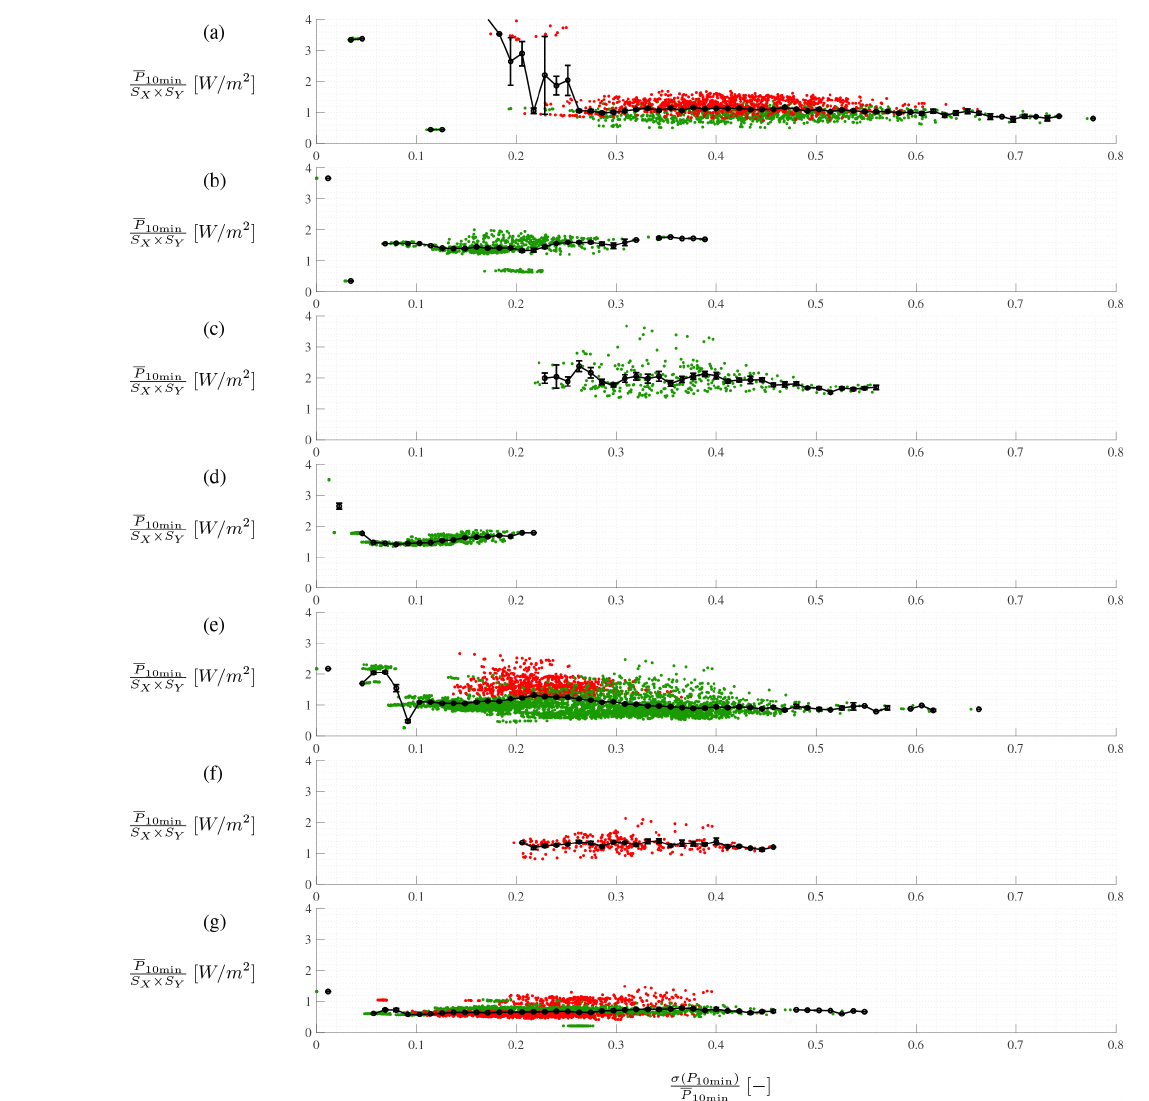
√ ( S X × S Y ) = 10 . 95 R , Figure 8. Power per ground area plotted against standard deviation of power normalized by mean power for (a) √ √ √ √ √ (b) ( S X × S Y ) = 12 . 00 R , (c) ( S X × S Y ) = 12 . 65 R , (d) ( S X × S Y ) = 14 . 00 R , (e) ( S X × S Y ) = 15 . 49 R , (f) ( S X × S Y ) = 16 . 73 R √ and (g) ( S X × S Y ) = 20 . 00 R . The green dots indicate results with low atmospheric turbulence (TI = 0–3%), while the red dots indicate results for high turbulence (TI = 10–15%). The black dots show bin-averaged values including the standard error plotted as error bars.